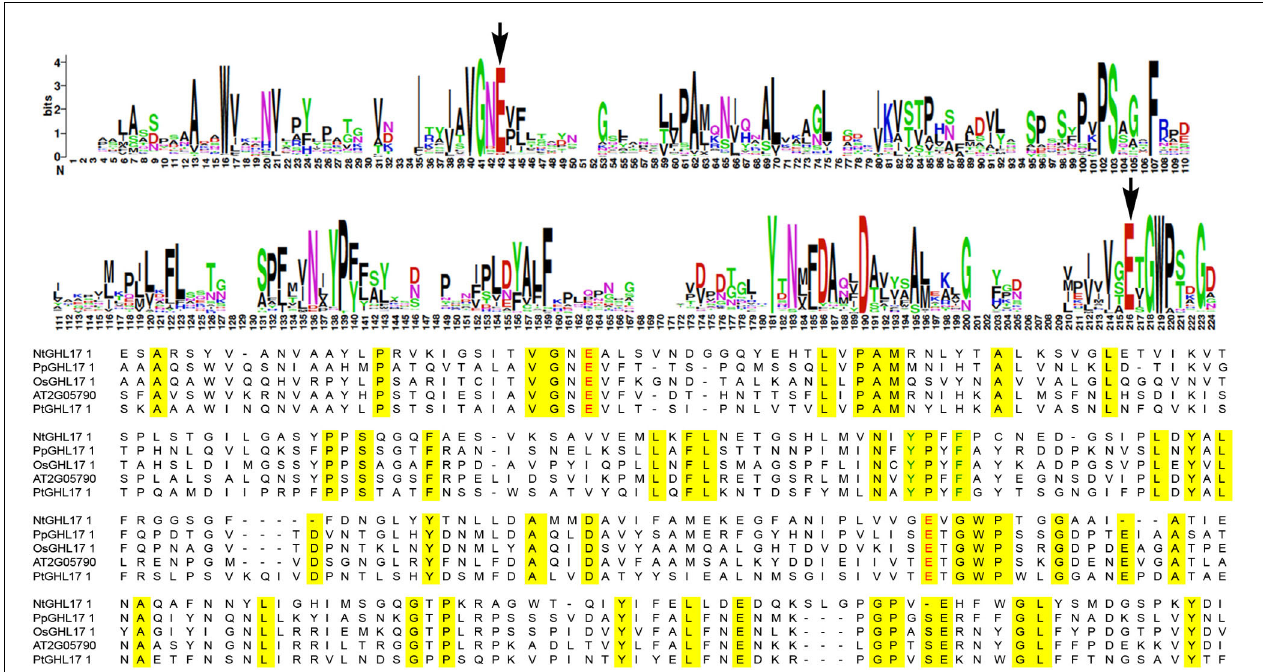
FIGURE 2 | Sequence conservation in the domain region of GHL17 proteins. The top panels show the consensus region for GH17 using weblogo. This was obtained by aligning all the sequences isolated from green algae and embryophytes (consult Table 1 to obtain the NCBI identifier for these sequences). The bottom panel shows an alignment of representative domain sequences from Nitella mirabilis (NtGHL17_1), from moss (PpGHL17_1) and from the vascular plants Arabidopsis thaliana (At2G05790),